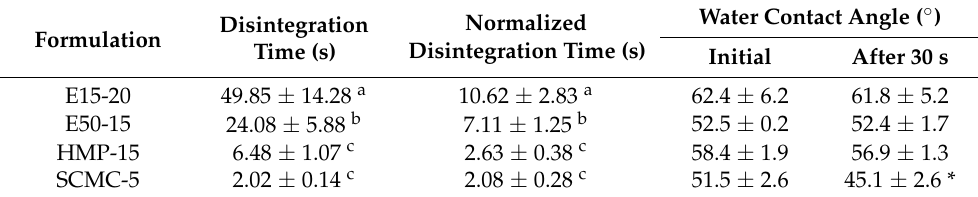
Table 6. In vitro disintegration time and water contact angles of 3D-printed